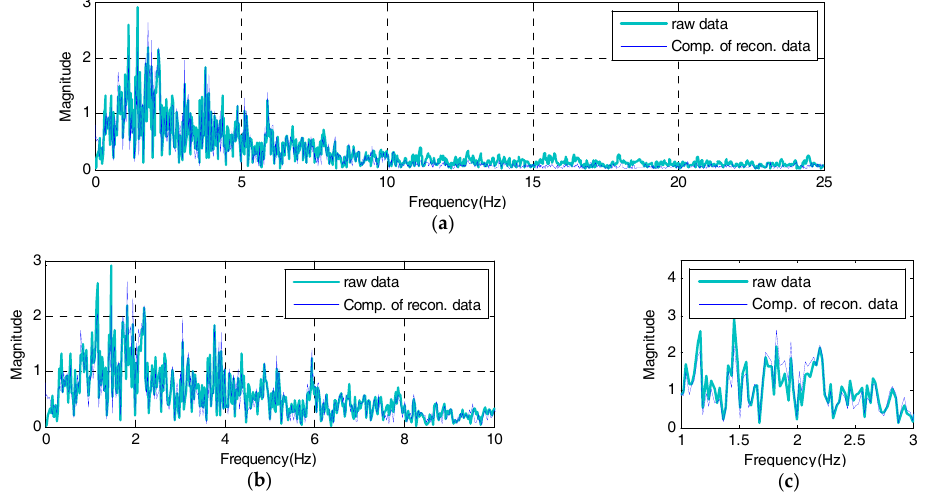
Figure 20. Frequency domain of raw signal vs. compressive signal: ( a ) frequency from 0 to 25 Hz; ( b ) Detail 1; ( c ) Detail 2.